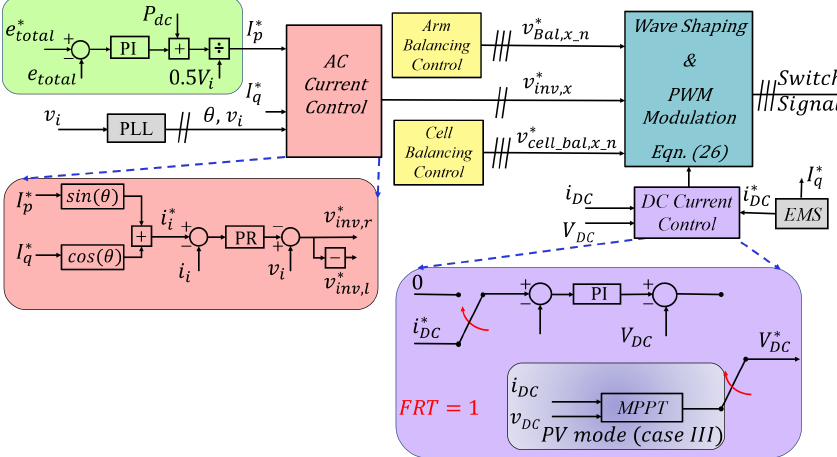
Figure 5. General control strategy for proposed